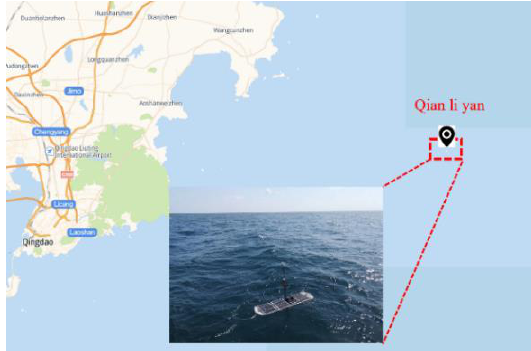
Figure 30. The “ Black Pearl ” wave glider in the sea trial. Figure 30. The “Black Pearl” wave glider in the sea trial.